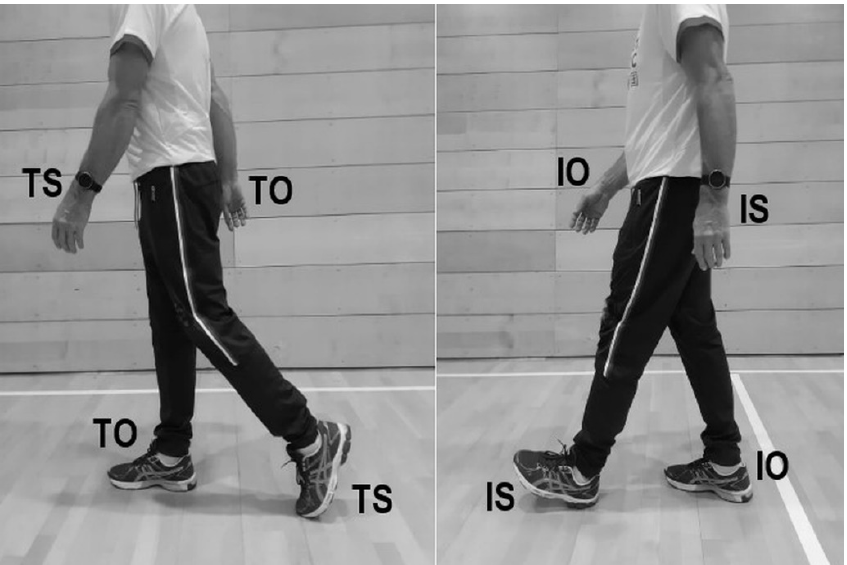
Figure 1. Limb labels in initiation (I) and termination (T) points of the gait cycle. The circles label the leg defining I ( left ) and T ( right ). IS marks a leg that defines initiation phase and the same-side arm. IO marks the limbs of opposite side during I. TS marks a leg that defines termination phase and the same-side arm. TO marks the limbs of opposite side during T.